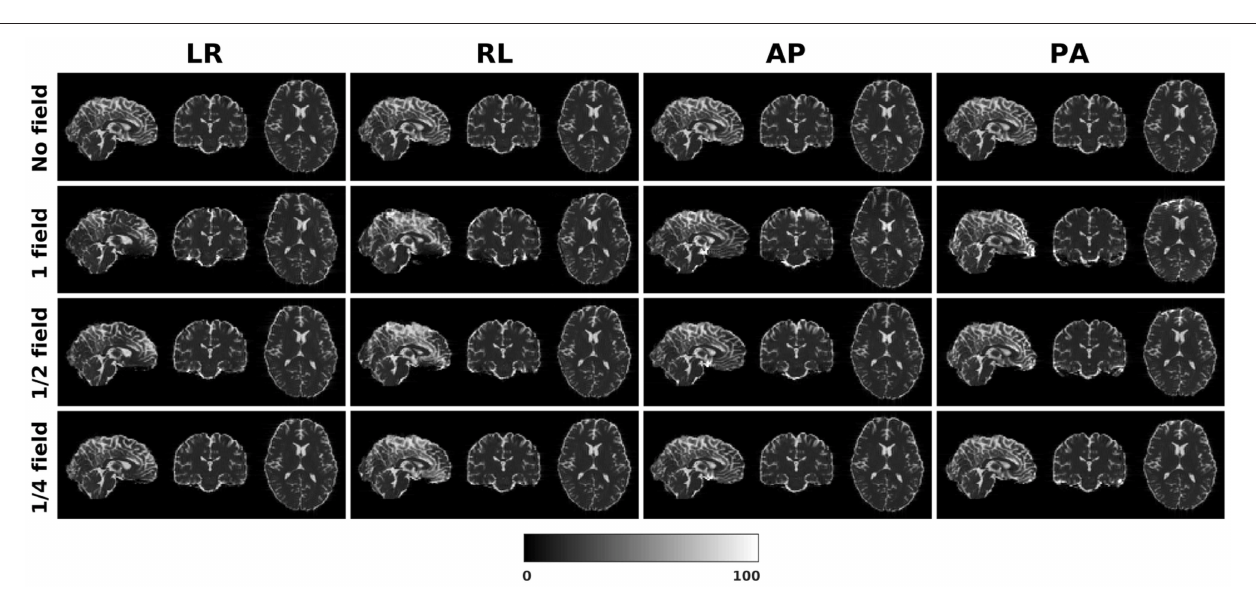
Frontiers in Neuroinformatics |